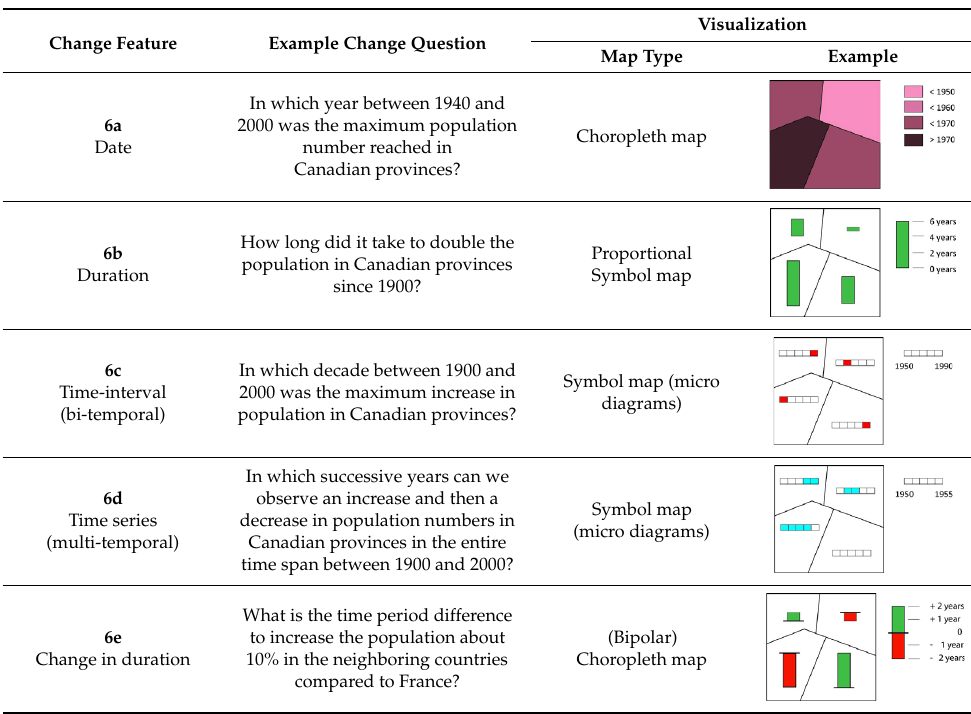
Table 6. Visualization of “When” output clauses (compare classification in Table 3).